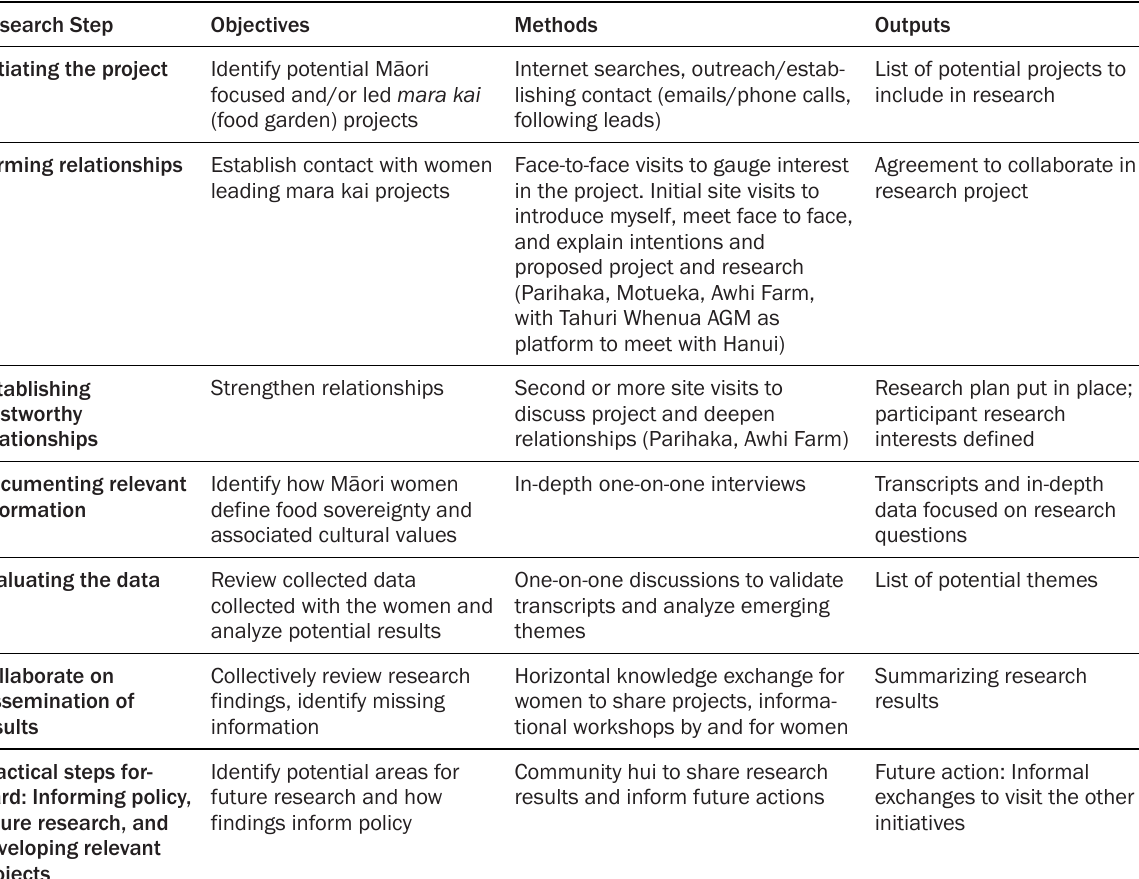
Table 2. Summary of Participatory/Kaupapa Research Process Specific to